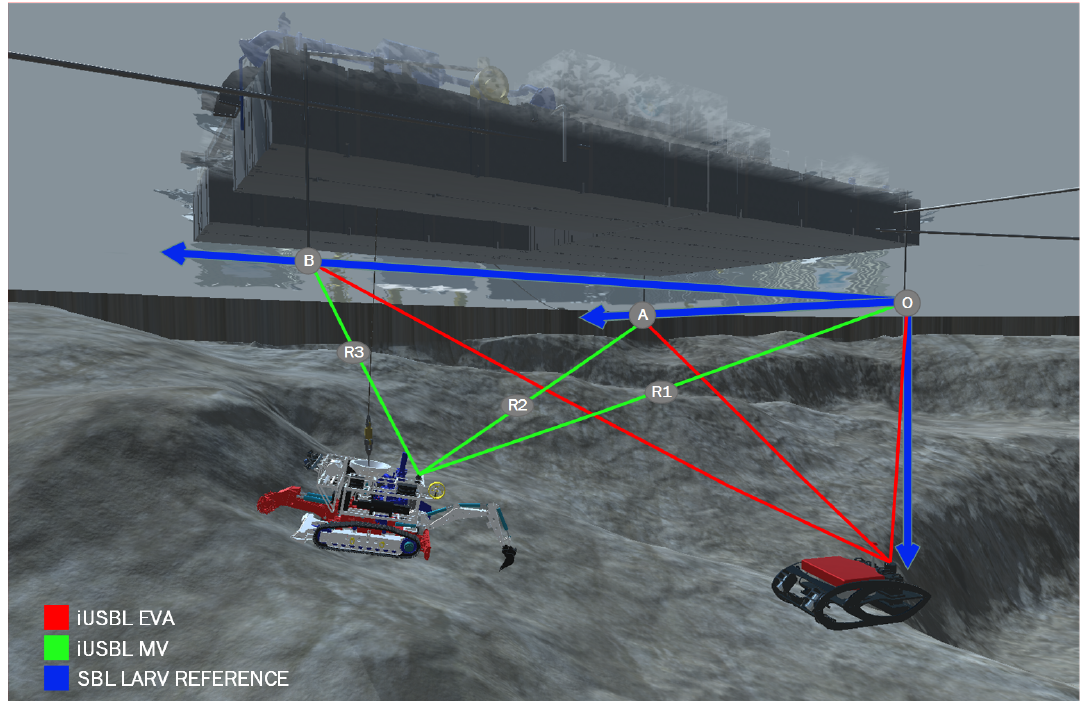
Figure 6. Interaction between the SBL network on the LARV and the iUSBL on the MV and